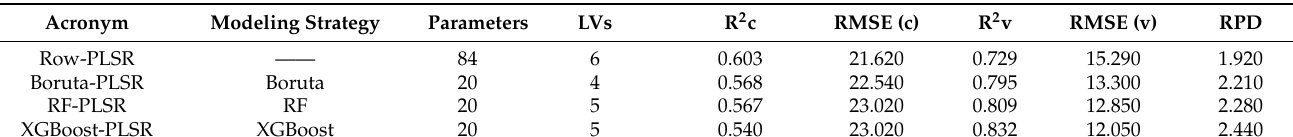
Table 7. Comparisons of partial least-squares regression (PLSR) models of soil salinity inversion based on different modeling strategies (dS m − 1 ).